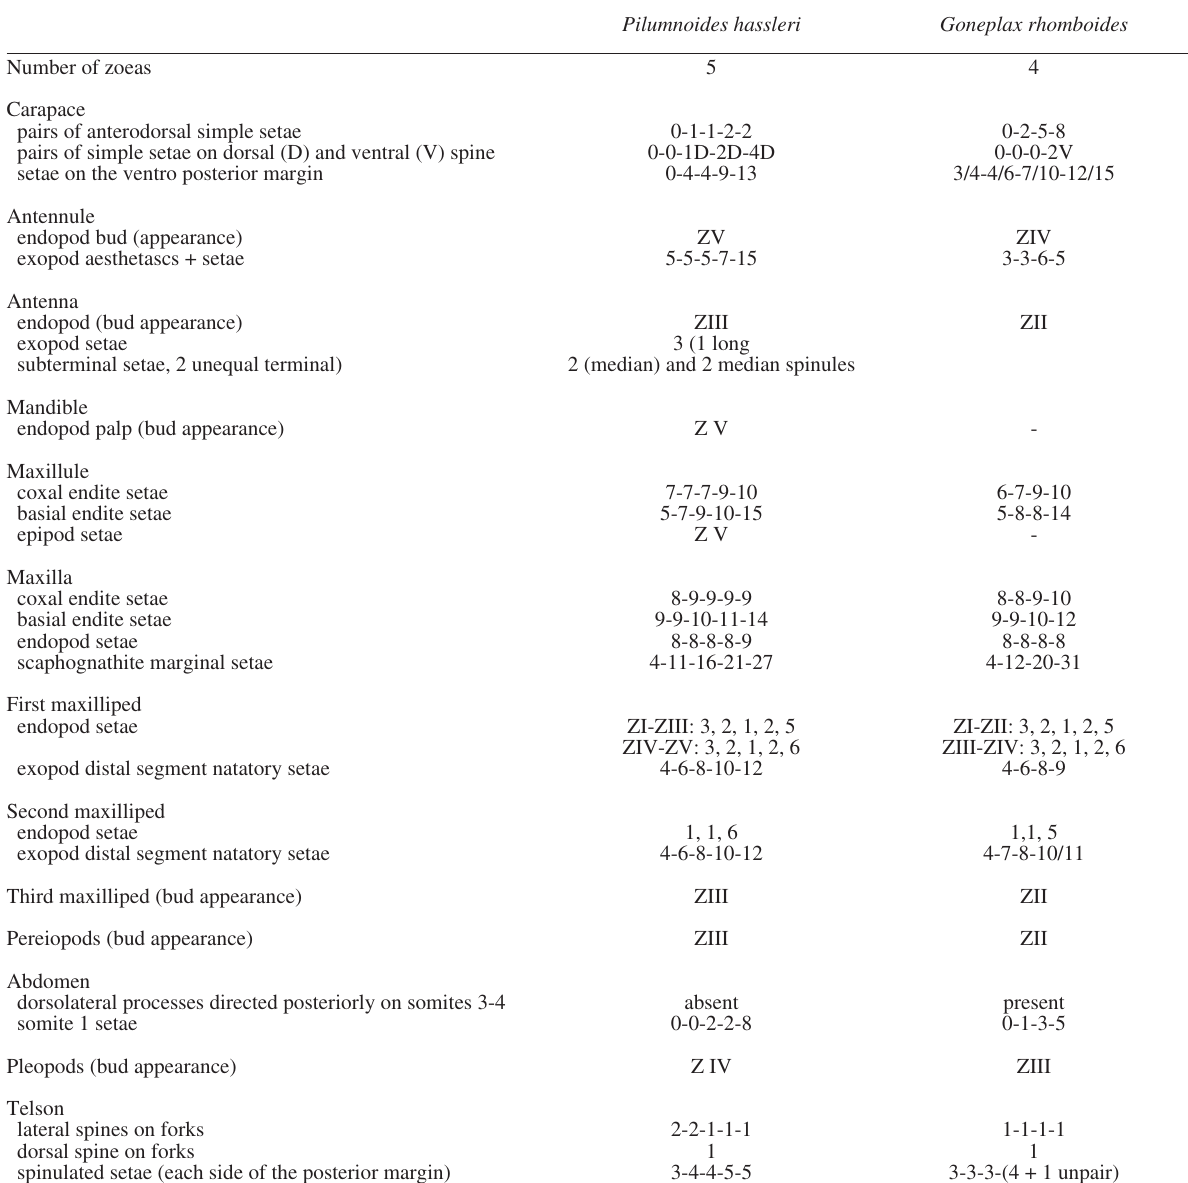
Table 5. – difference between the zoeal morphology (all stages) of Pilumnoides hassleri and Goneplax rhomboides (Linnaeus, 1758) de- scribed by ingle and Clark